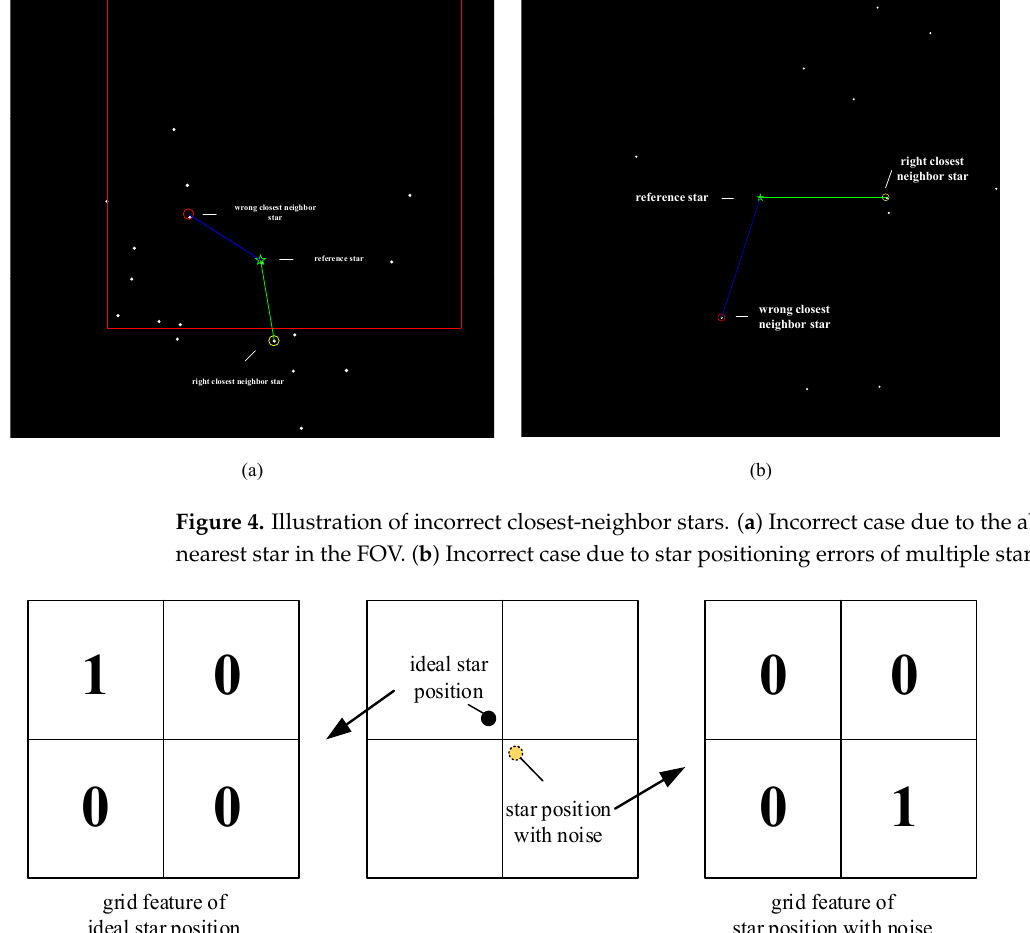
Figure 5. Demonstration of the poor positioning tolerance of traditional feature extraction.